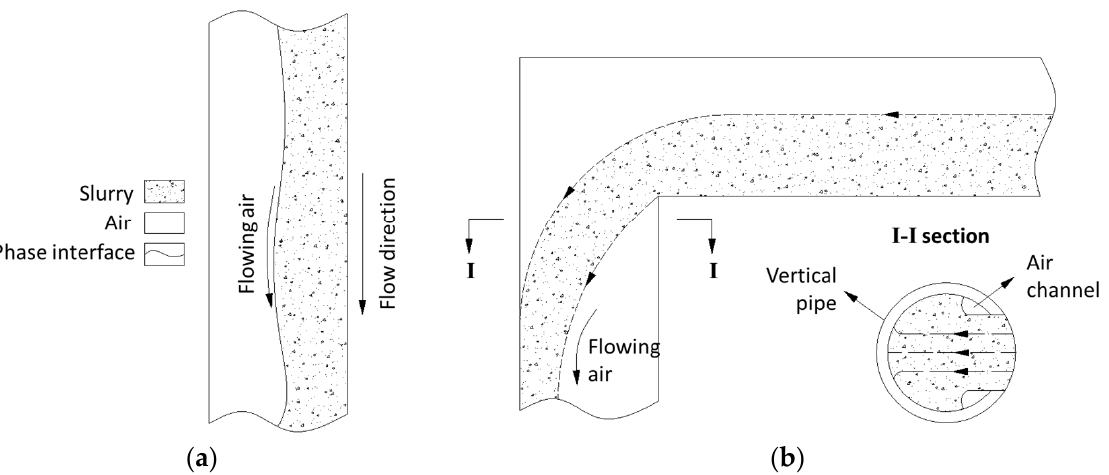
Figure 13. Partly-filled pipe-flow in Zone 1 in the case of ( a ) experimental pipeline system and ( b ) practical pipeline system.